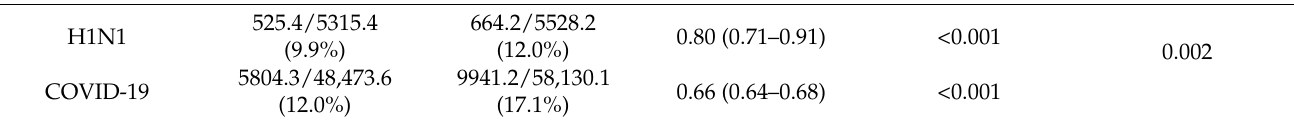
death in pregnant women remained significant (OR 0.80; 95% CI 0.71–0.91 for H1N1 vs.